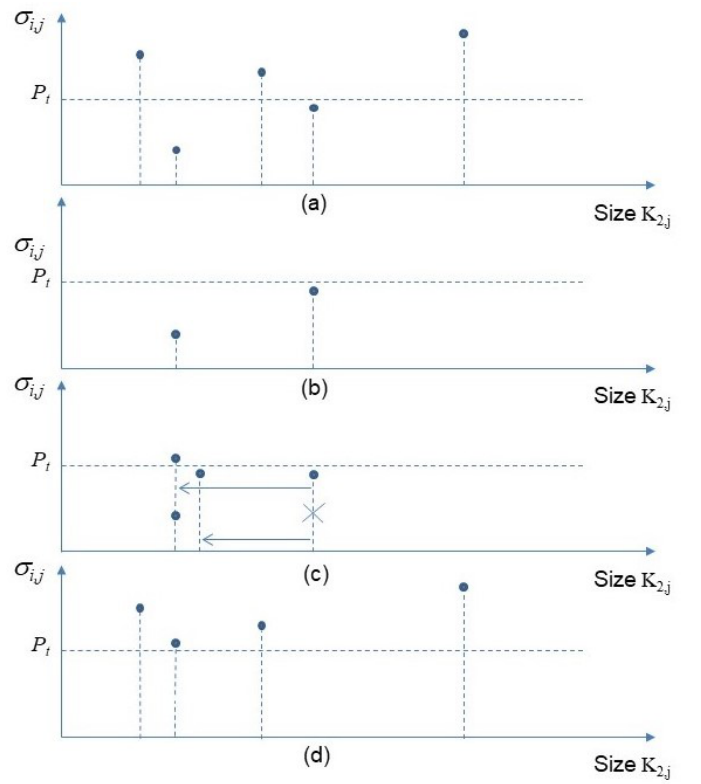
Figure 4. Cache processing procedure: ( a ): Physical caches; ( b ): Physical caches under probability threshold; ( c ): Cache combination; ( d ): Virtual